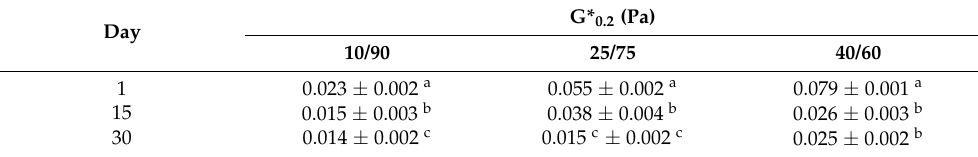
Table 7. Encapsulation efficiency (E E ) as a function of time (1, 15 and 30 days) obtained for W 1 /O/W 2 multiple emulsions at three different O/W ratios for the secondary emulsion (10/90, 25/75 and 40/60). Different superscript letters within a column indicate significant differences ( p <